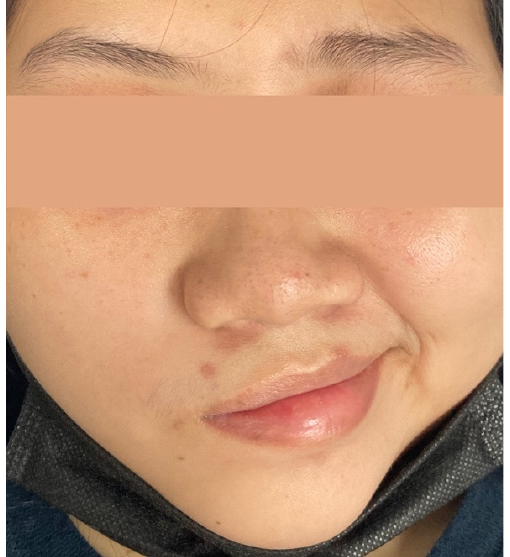
Figure 1. Image of the neurological status of the patient on admission. Multiple cranial nerve (CN) palsies (right CN V, VII, IX, and X); asymmetrical eyebrows; incomplete right eye closure; and complete loss of right nasolabial fold (House–Brackmann facial nerve grade VI) can be observed. On the sixth day after the onset of the symptoms, she complained of pain under the right ear. There was a point of tenderness just below the right temporomandibular joint.